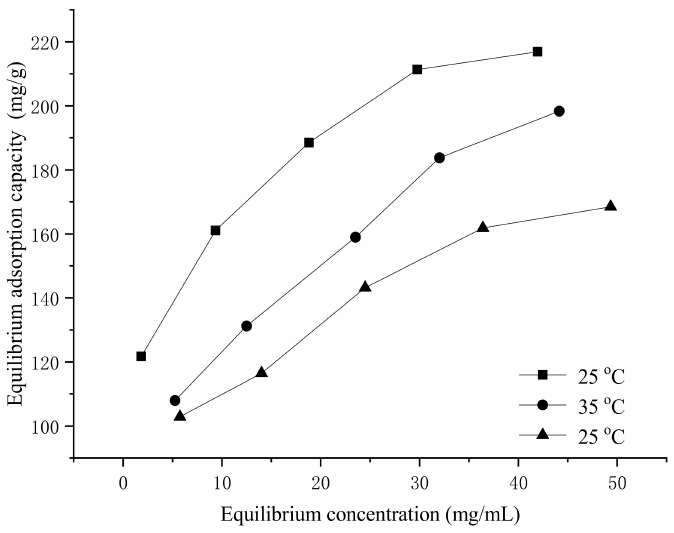
Figure 3. Adsorption isotherm of XDA-1 resin on the amygdalin.